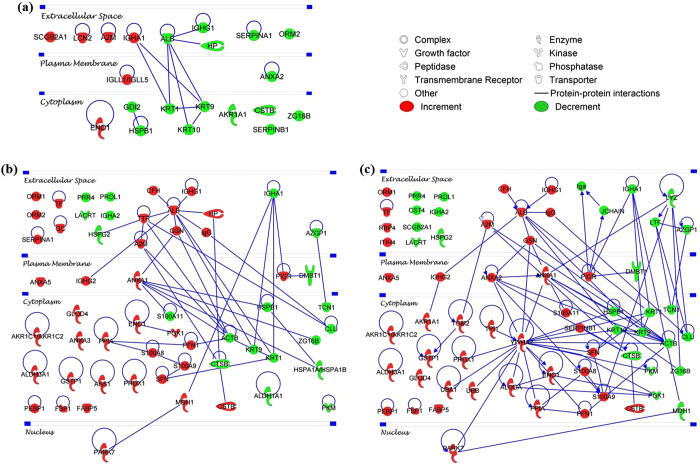
Networks of PPI of the significantly differentially expressed tear proteins analysed employing the Ingenuity Pathways Analysis software in (a) DRYlip vs. CTRL, (b) DRYaq vs. CTRL and (c) DRYaqlip vs. CTRL.